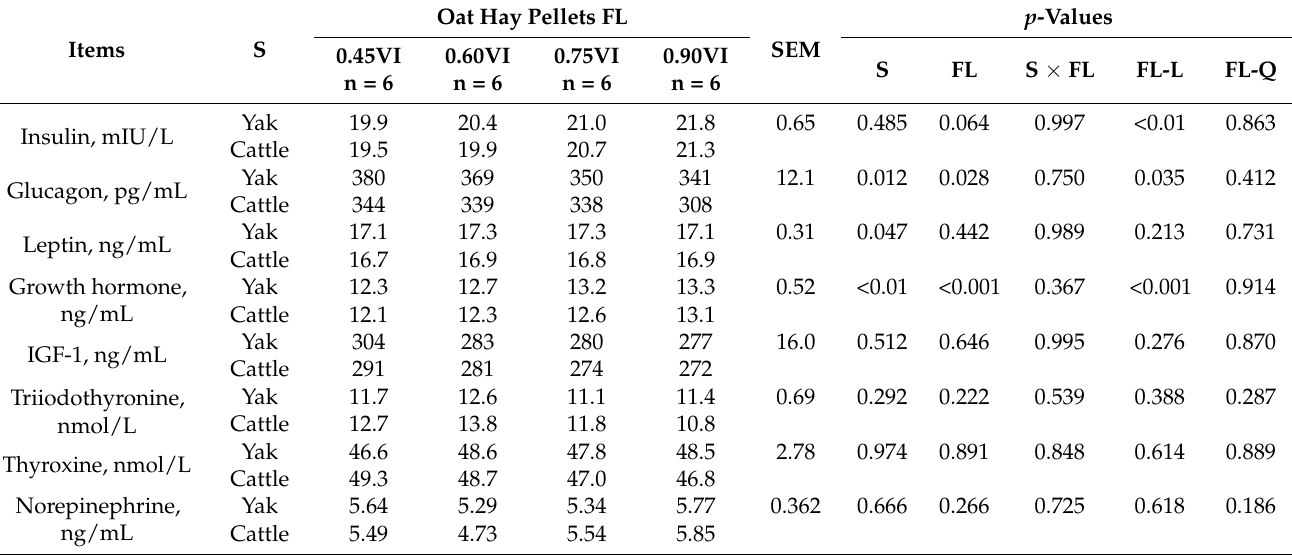
Table 6. The serum hormones concentrations in yaks and in cattle offered oat hay pellets at different feeding